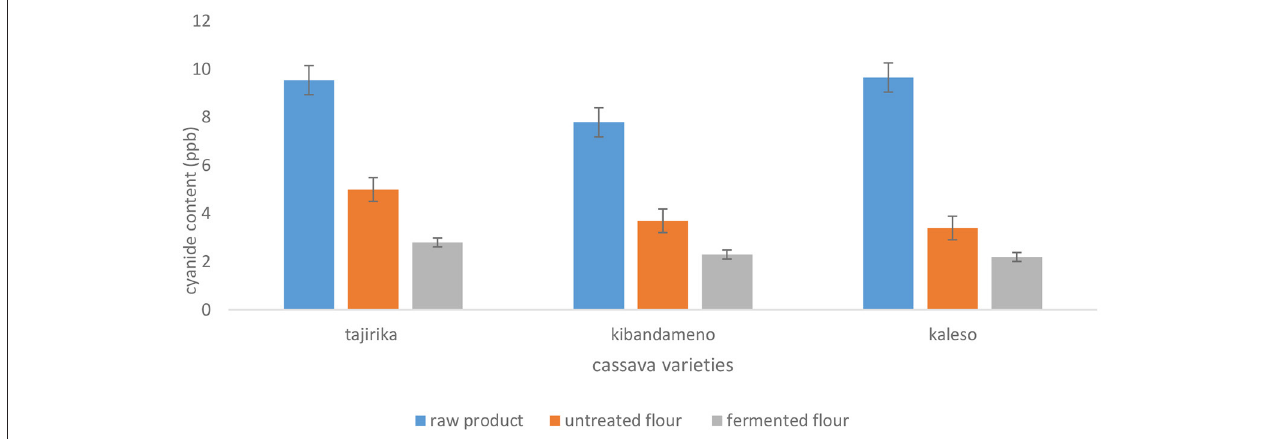
FIGURE 1 | Effect of pre-treatment processes on the cyanide content of cassava roots. The bars are standard error bars.